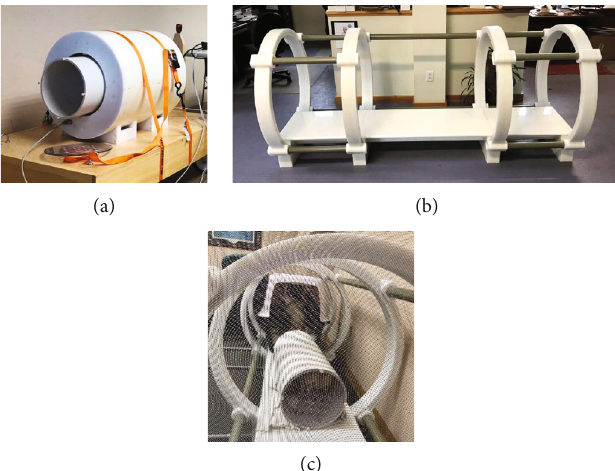
Figure 1: The photograph in (a) depicts the toroidal device used to deliver the uniform PEFs with to open VGSCs; maximum fi eld amplitude of 6V/m. The photograph in (b) depicts the coaxial ring device used to deliver PEFs with a fi eld amplitude of 18 V/m. (c) Dogs in the carriers that allowed room for ad libitum movement to adjust position for comfort during the period of stimulation while being treated with TOL.